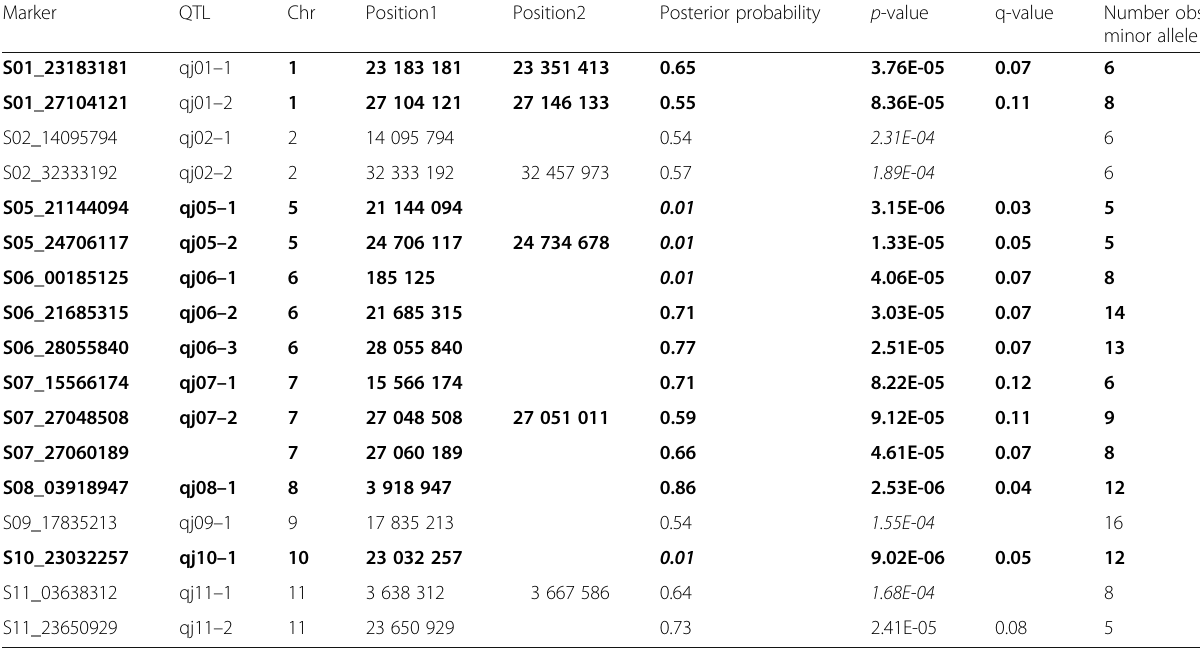
Table 5 Markers significant in the GBS japonica panel